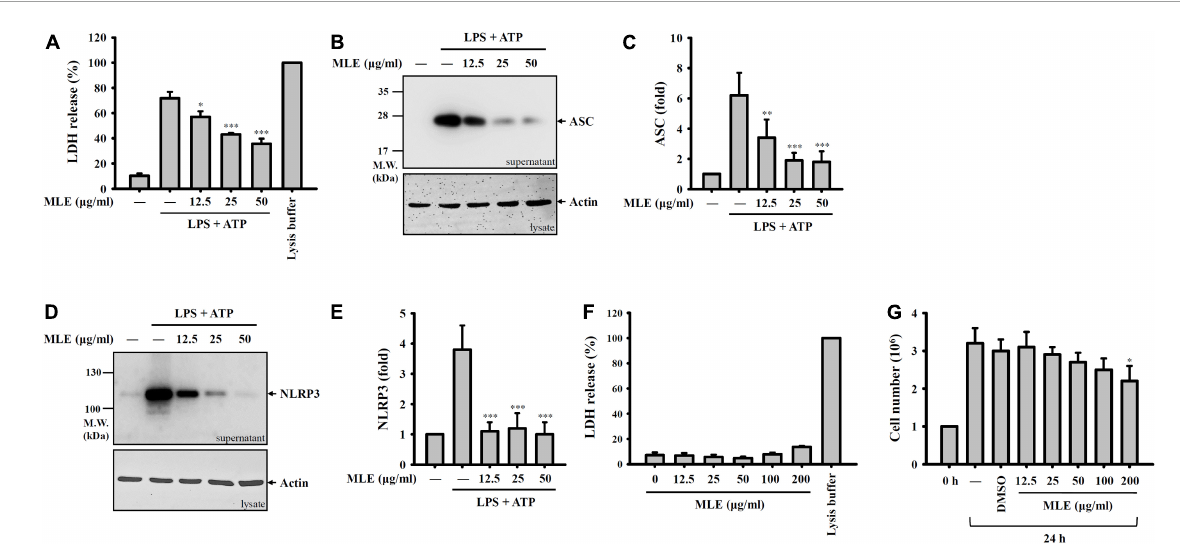
FIGURE2 MLE inhibits pyroptosis. (A–E) LPS-primed J774A.1 macrophages were incubated with MEL for 0.5 h before ATP stimulation for an additional 0.5 h. The levels of LDH in the supernatants were analyzed by an LDH release kit (A) , and the levels of ASC in the supernatants were analyzed by western blot (B) . (C) The column diagram represents the fold change of ASC in (B) compared with the control group analyzed by ImageJ. (D) The levels of NLRP3 in the supernatants were analyzed by western blot. (E) The column diagram represents the fold change of NLRP3 in (D) compared with the control group analyzed by ImageJ. (F) J774A.1 macrophages were incubated with MEL for 24 h, and the levels of LDH in the supernatants were analyzed by an LDH release kit. (G) J774A.1 macrophages were incubated with MEL for 24 h, and the cell numbers were calculated by the Trypan Blue exclusion test of cell viability. The western blot images are representative of three different experiments. The LDH and cell counting data are expressed as the mean ± SD of three separate experiments. * p < 0.05, ** p < 0.01, and *** p < 0.001 compared to the LPS + ATP group in (A–E) or compared to the vehicle-treated group in (G)